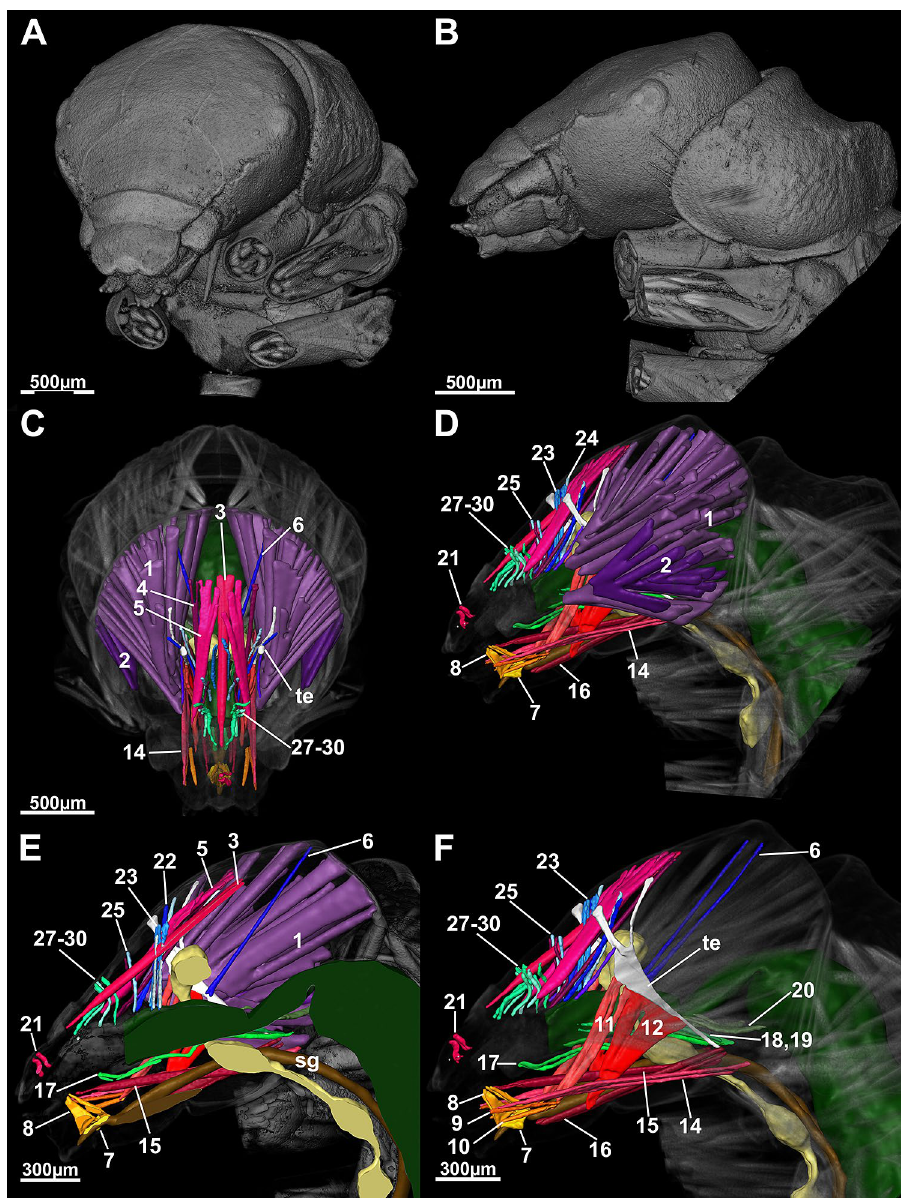
Figure 2. 3D-reconstruction of the morphology ( A , left fronto-lateral view, B , lateral view) and the internal head anatomy ( C , frontal view, D , lateral view, E , sagittal view, F , parasagittal plane at the level of the tentorium) of Drusus bosnicus (5th larval instar) based on µCT data. Abbreviations: 1 = Musculus (M.) cranio-mandibularis medialis, 2 = M. cranio-mandibularis lateralis, 3 = M. fronto-labralis, 4 = M. fronto-pharyngalis, 5 = M. fronto- epipharyngalis, 6 = M. cranio-postpharyngalis dorsalis, 7 = M. praemento-salivaris, 8 = M. hypopharyngo- salivarialis, 9. = M. basistipito-dististipitalis lateralis, 10 = M. basistipito-dististipitalis medialis, 11 = M. tentorio- stipitalis, 12 = M. tentorio-cardinalis, 14 = M. cranio-dististipitalis, 15 = M. cranio-praementalis medialis, 16 = M. cranio-praementalis lateralis, 17 = M. cranio-cibarialis, 18 = M. cranio-pharyngalis anterior, 19 = M. cranio- pharyngalis posterior, 20 = M. cranio-postpharyngalis ventralis, 21 = M. labro-epipharyngalis, 22 = M. cranio- pharyngalis lateralis, 23 = M. fronto-pharyngalis medialis, 24 = M. fronto-pharyngalis lateralis, 25 and 26 = M. fronto-pharyngalis ventralis, 27 and 28 = M. clypeo-pharyngalis, 29 and 30 = M. clypeo-cibarialis, te = tentorium. The figure was built using the visualization software Amira 2020.2 (Thermo Fisher Scientific, https:// www. therm ofish er.